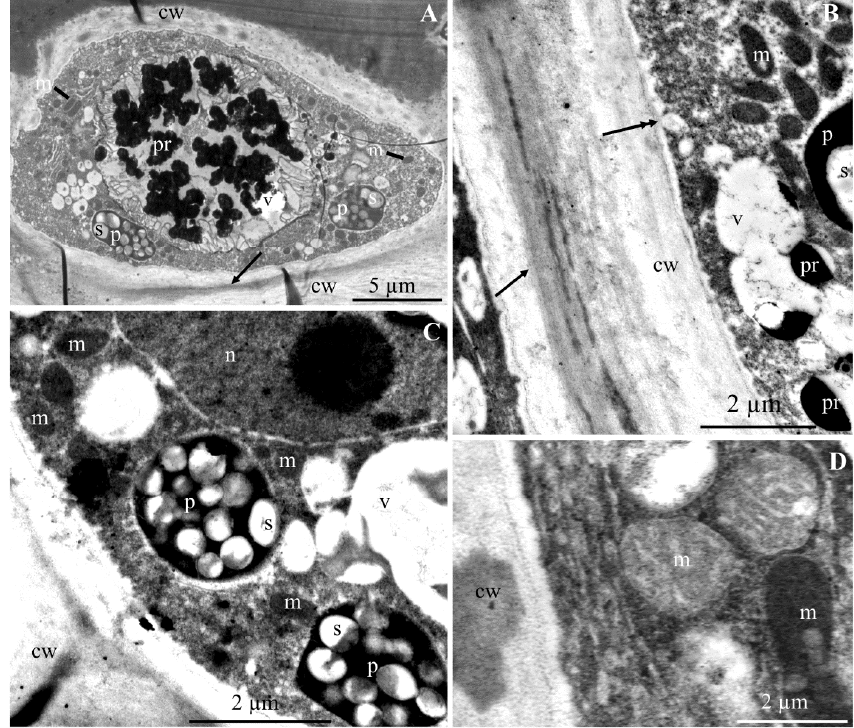
Figure 4. Fragments of the cross sections of epidermis cells from the apical part of ‘Szampion’ apples from the CaCl 2 foliar feeding treatments. A , B : cell wall (cw), visible middle lamella (arrow), dense cytoplasm, plastids (p) with starch grains (s), numerous mitochondria (m), vesicular invaginations of the plasmalemma (double-headed arrow) (Figure 4B), vacuole (v), precipitates in cell sap (pr). C : protoplast, visible electron dense nucleoplasm of the cell nucleus (n) with a nucleolus, amyloplasts (p) with starch grains (s), mitochondria (m), vacuole (v). D : mitochondria (m) located near the plasmalemma, visible cell wall (cw) and electron dense cytoplasm.